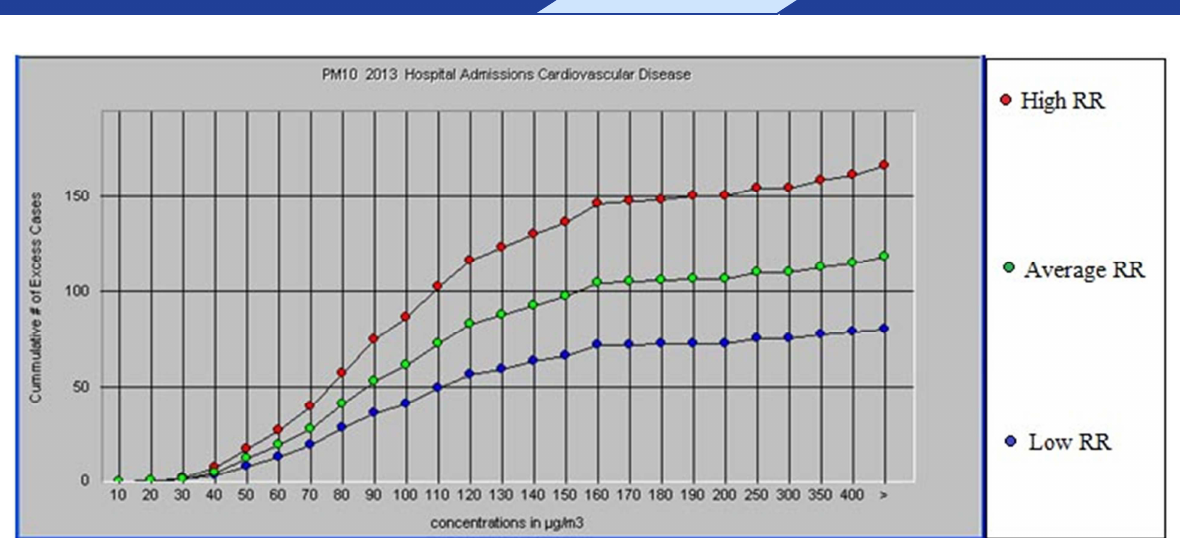
Figure 8. Estimated cumulative number of hospital admission cardiovascular diseases cases attributable to particulate matter with aerodynamic diameters <10 µm comparing concentration intervals (Sanandaj, Iran, 2013 )